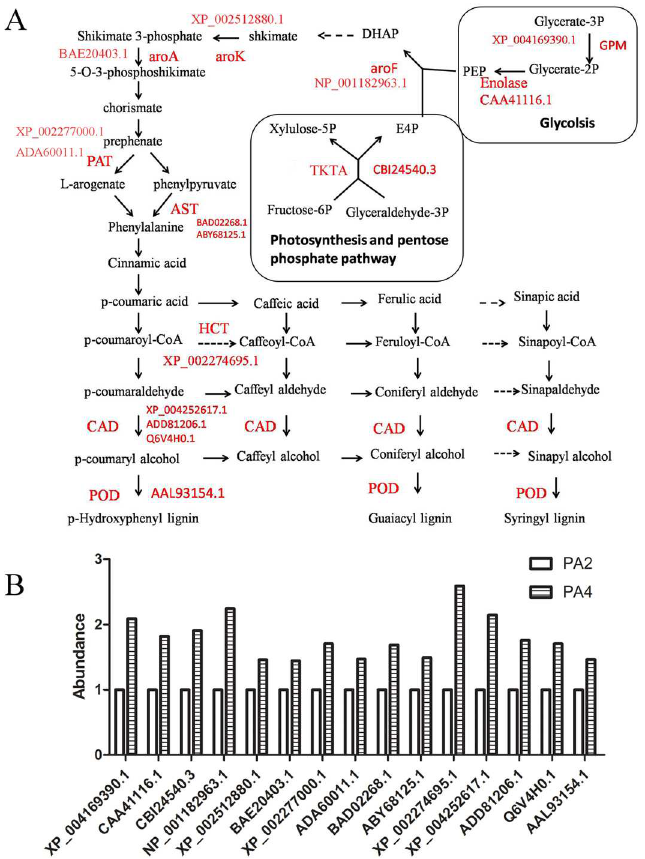
Fig 9. Lignin biosynthesis-associated differentially abundant proteins. (A) A diagramshows the intermediates and enzymes involvedin ligninbiosynthesispathwayin P . australis .(B) The abundance of differentially abundantproteins. The abundance of proteins in PA2 was 1. TKTA: transketolase, GPM: phosphoglyceratemutase, aroF: 3-deoxy-7-phosphoheptulonatesynthase, aroK: shikimate kinase, aroA: 5-enol-pyruvylshikimate-3-phosphate synthase, PAT: glutamate/aspartate-prephenateaminotransferase, AST: aspartatetransaminase, HCT: shikimate/quinate hydroxyl cinnamoyltransferase, CAD: cinnamyl alcoholdehydrogenase, POD: